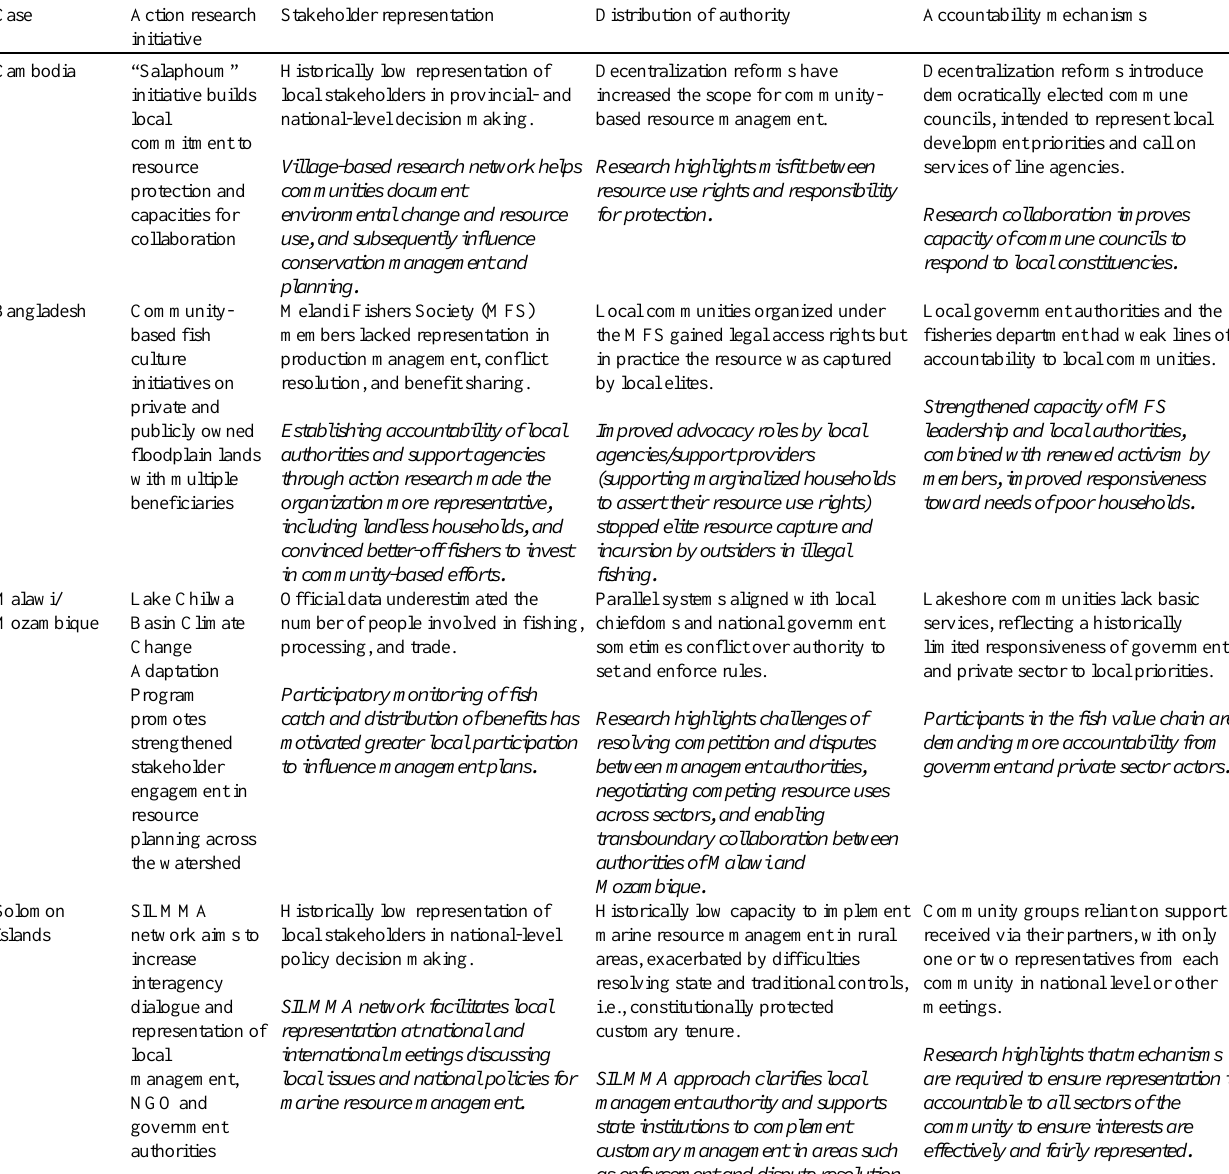
Table 1 . Key observations from case studies. Outcomes of action research are shown in